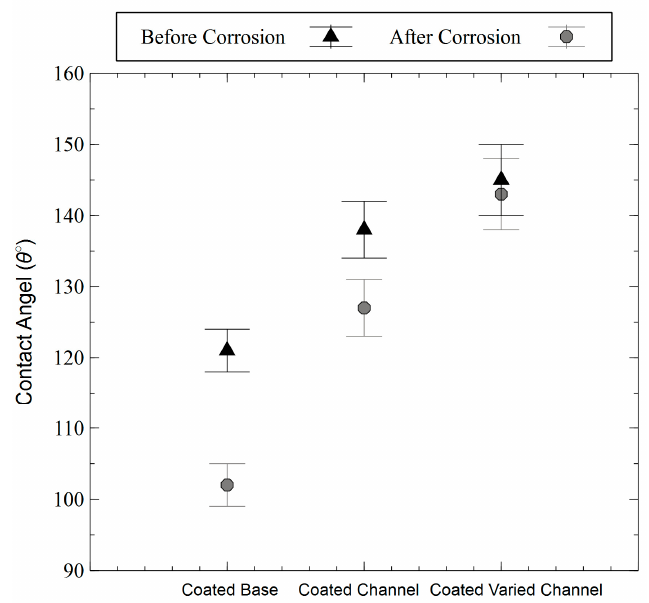
Figure 8. Contact angle (in degrees) comparison before and after the potentiodynamic polarization tests.